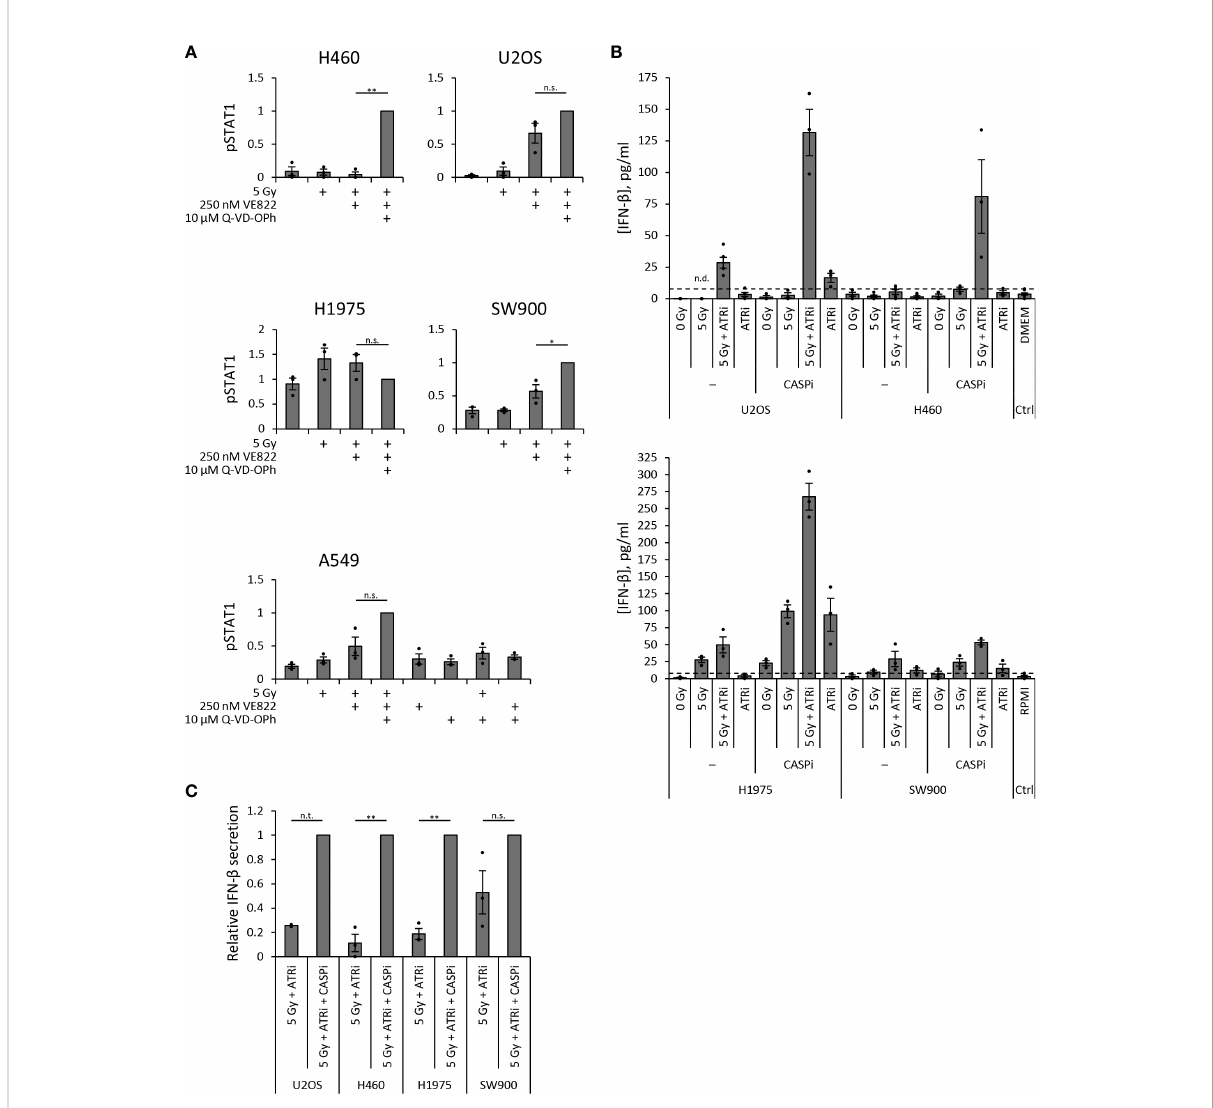
FIGURE 6 Caspase inhibition increases secreted IFN- b . (A) Quanti fi cation of pSTAT1 levels from three independent immunoblot experiments in each cell line at three days (H460, U2OS, H1975, SW900) or six days (A549) post treatment. Values are relative to g -tubulin or total protein and normalized to the triple-treated sample. One sample t test was conducted for differences between co-treated (5 Gy + ATRi) and triple-treated (5 Gy + ATRi + CASPi) samples. (B) ELISA measurements of secreted IFN- b in 20X upconcentrated growth medium supernatants from samples three days after IR and ATRi. ATRi: 250 nM VE822, CASPi: 10 µM Q-VD-OPh (24 – 72 h). Top: U2OS and H460 with DMEM medium control; bottom: H1975 and SW900 with RPMI medium control. Results from Figures 2H and 3E are included in the plots for U2OS and H460 without CASPi. (C) The IFN- b values in (B) for co-treated (5 Gy + ATRi) normalized to the values for triple-treated (5 Gy + ATRi + CASPi) samples. (n.t.: not tested (U2OS, n = 2), n.s.: not signi fi